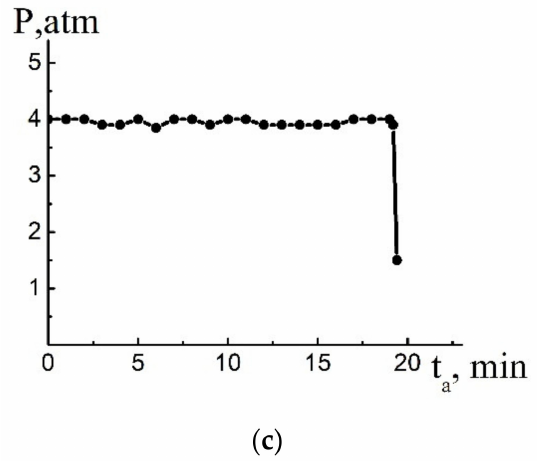
Figure 2. ( a ) Experimental dependences of the size of titanium particles, ( b ) the temperature on the external (curve 1) and internal (curve 2) surfaces of the mill wall, ( c ) nitrogen pressure in the mill on the mechanical activation time t a for m ∑ ,0 = 0.0037.